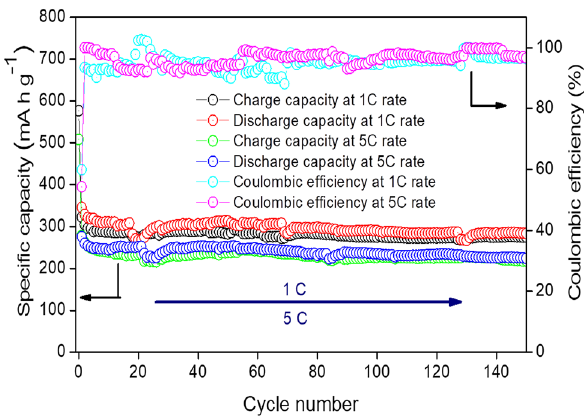
Fig. 9 Cycling performance and coulombic efficiency of B-TiO